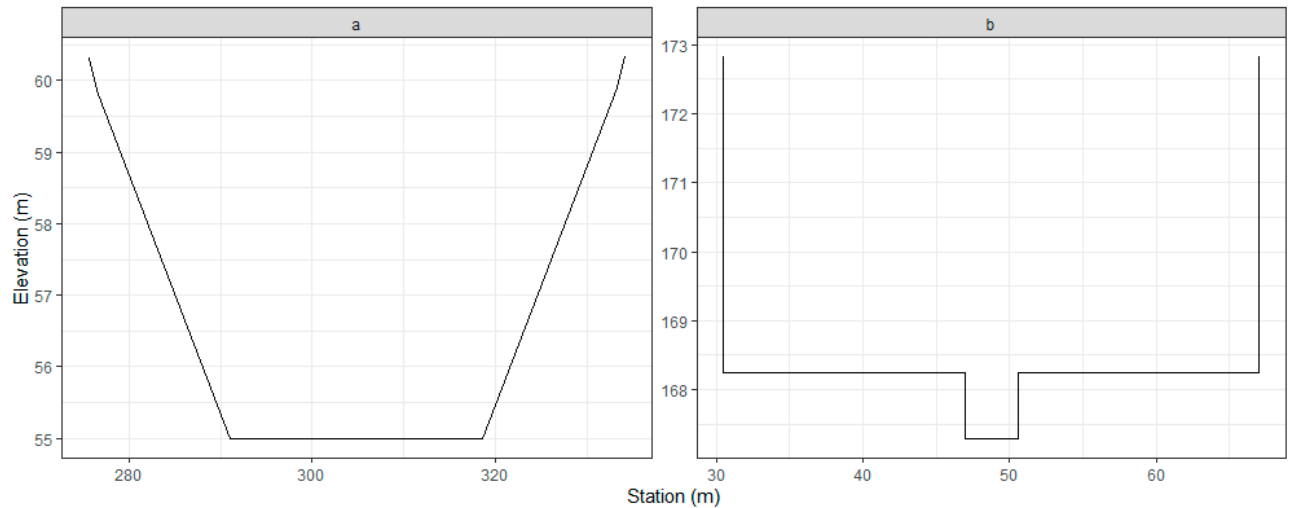
Figure 4. Two example cross-sections, ( a ) for a node within Rio Hondo (USGS 11102300, left) and ( b ) for a node within the mainstem of the Los Angeles River with a low-flow channel (F300, right).